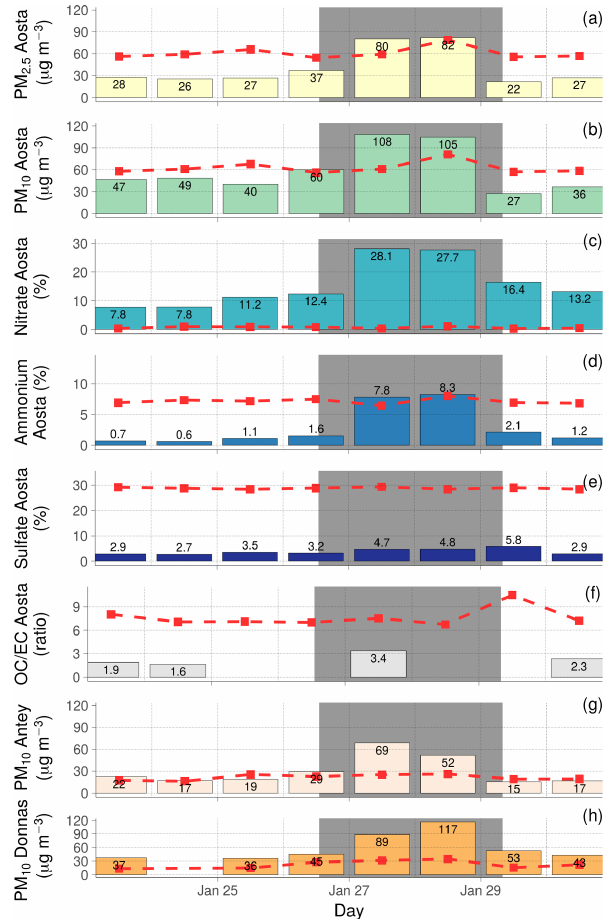
Figure 11. Measured (coloured bars) and simulated (dotted line) PM 2 . 5 and PM 10 daily concentrations at several sites of the Aosta Valley (a, b, g, h) ; percentage concentrations of nitrate (c) , ammo- nium (d) , and sulfate (e) and OC / EC ratio (f) at Aosta–downtown during case study 2 (January 2017). The period when the ALC de- tects a thick layer above Aosta–Saint-Christophe is highlighted with a grey